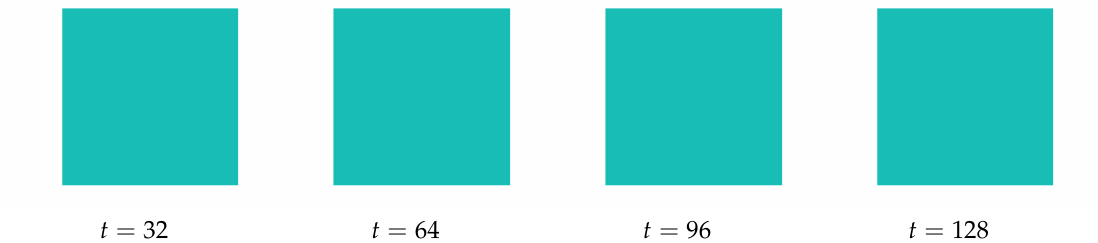
Figure 9. Evolution of φ ( x , y , t ) using the method OS2 with ∆ t = 2. In each snapshot, the yellow, green, and blue regions indicate φ = 0.3810, 0.0195, and